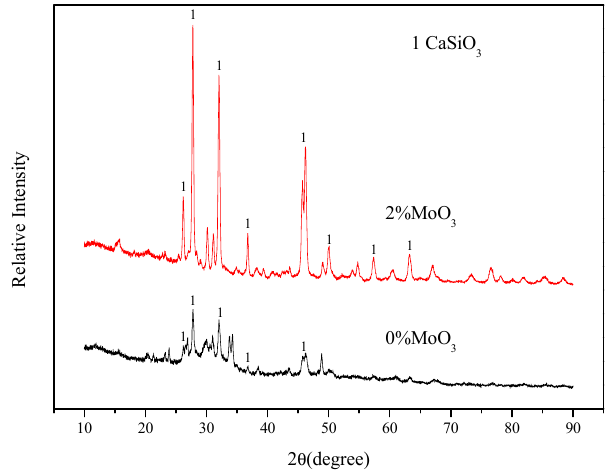
Figure 6. XRD patterns of samples heated at the crystallization temperature.